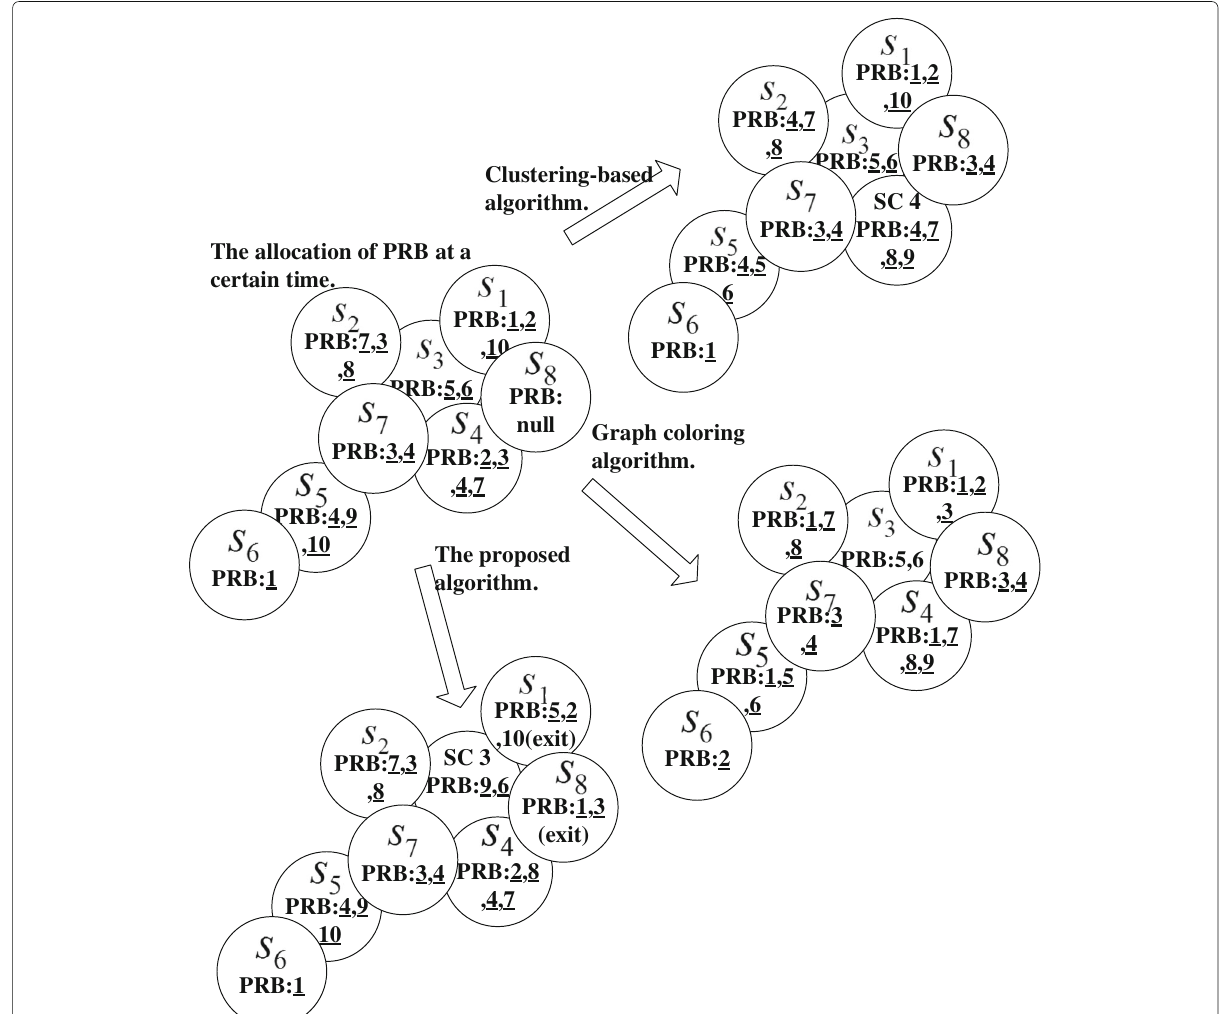
algorithm.Clustering-based algorithm. Graph coloring The proposed algorithm.